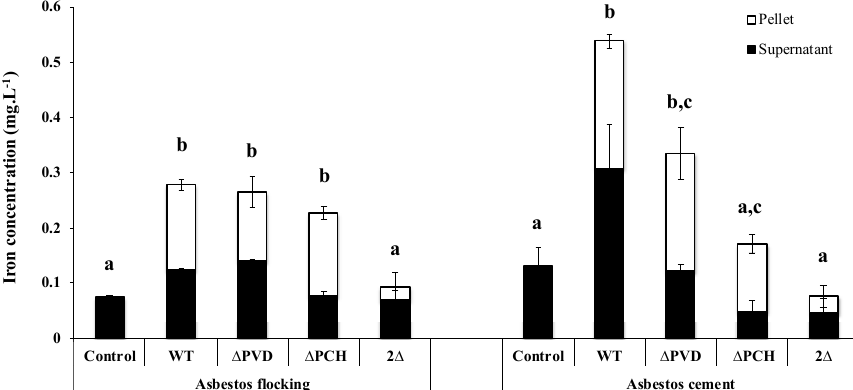
Figure 5. Concentration of iron dissolved after 18 h incubation from flocking asbestos waste or after 40 h incubation from asbestos cement in the presence of minimal casamino acids medium depleted in iron and magnesium as a control or inoculated with the wild type Pseudomonas aeruginosa PAO1 strain (WT), a pyoverdine-deficient strain ( ∆ PVD), a pyochelin-deficient strain ( ∆ PCH), or a pyoverdine- and pyochelin-deficient strain (2 ∆ ). The iron was measured in the bacterial cells (pellet) and supernatants to determine the total amount of total iron extracted. Error bars indicate the standard errors of the means of three replicates. Bars with the same letter are not significantly di ff erent ( p ≥ 0.05, one-way ANOVA for flocking asbestos waste and Kruskal–Wallis test for asbestos cement, three replicates). Adapted from David et al.